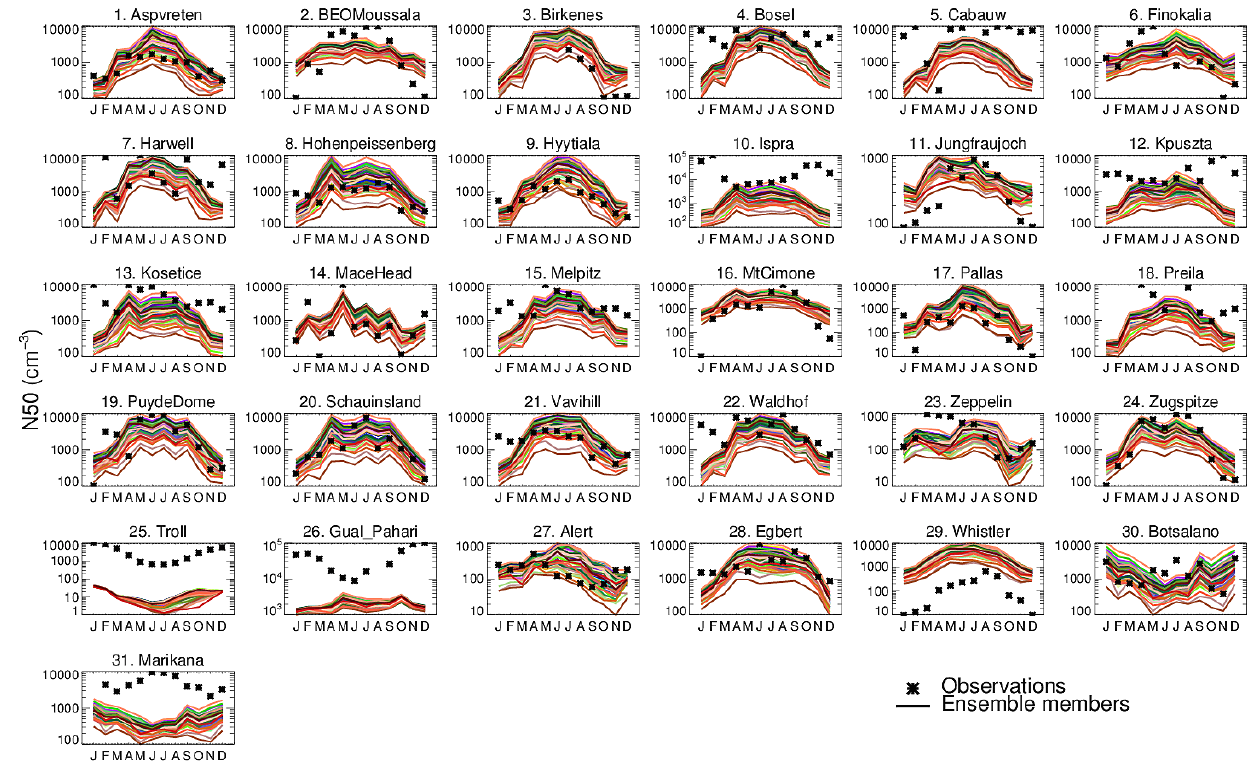
Figure 9. Seasonal cycle of simulated (solid coloured lines) and observed (black stars) monthly mean surface-level N50 concentrations at 31 ground-based sites. Each coloured line is an ensemble